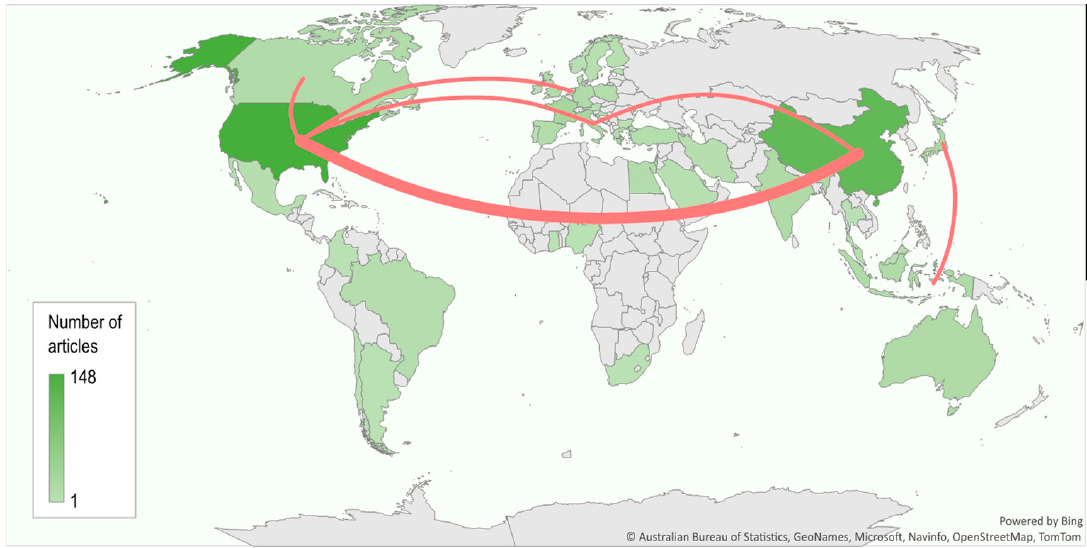
Figure 14. Countries’ collaboration map indicating the number of documents (green) for every country and the main collaboration among the countries (orange) (WoSCC and Scopus databases).